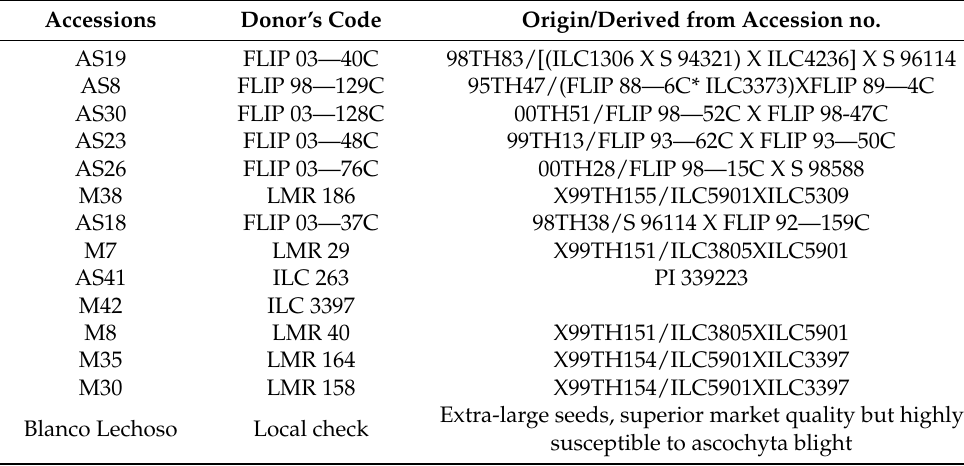
Table 1. Chickpea accessions included in the study.